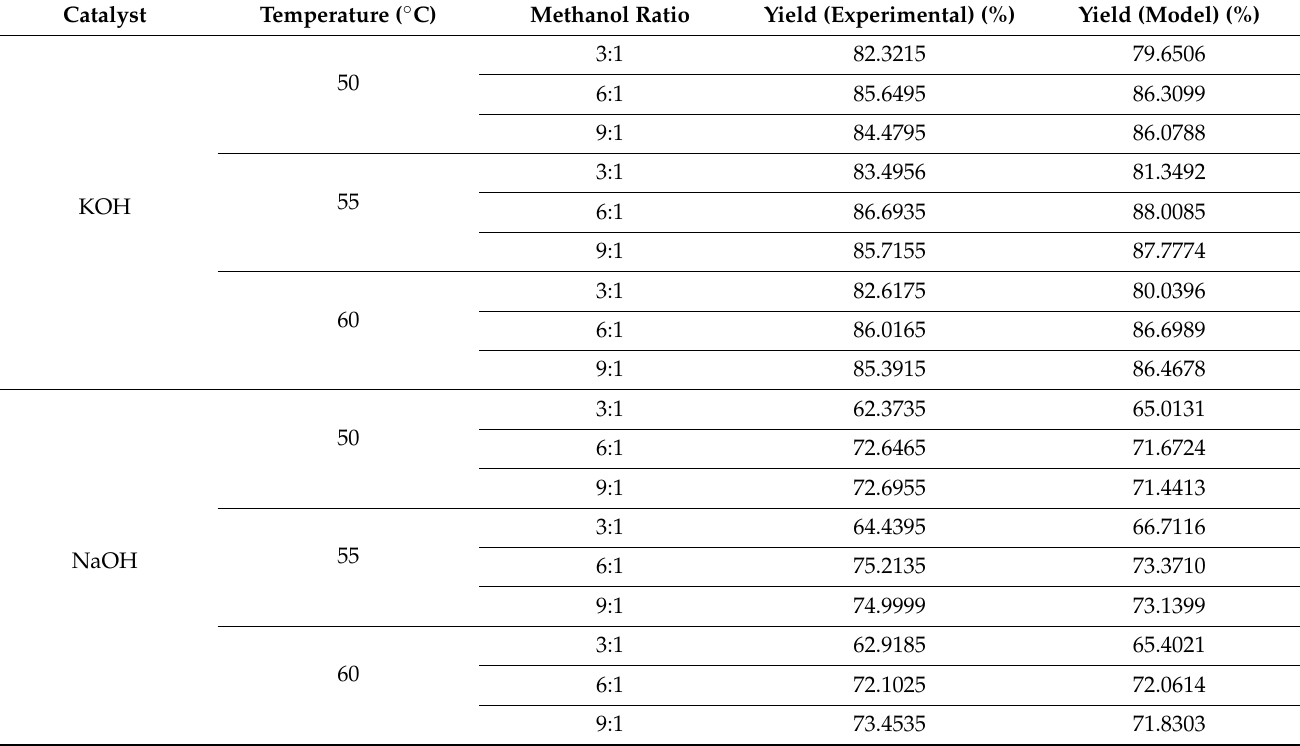
Table 3. Yield (%) of PKO